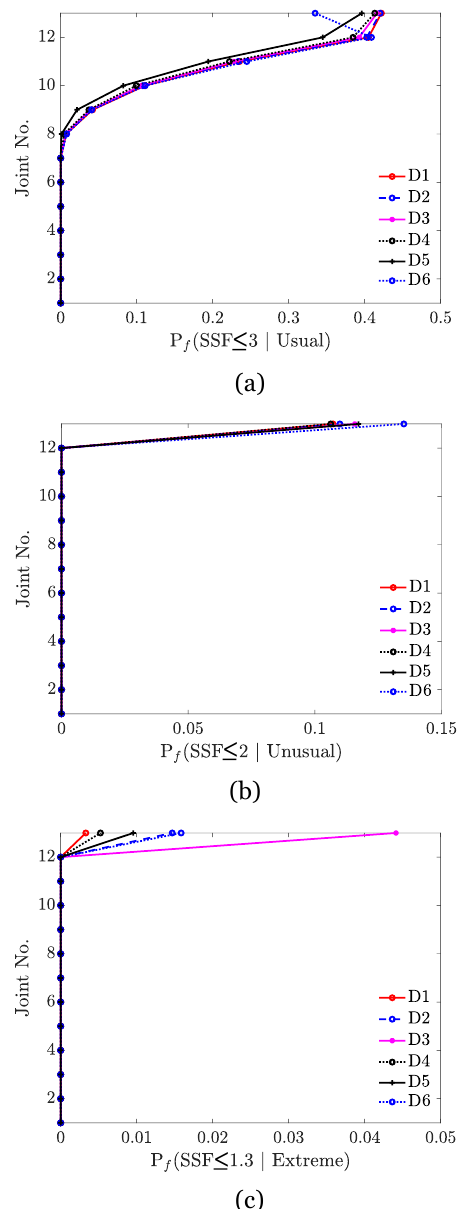
Figure 11. Conditional probability functions: ( a ) usual, ( b ) unusual, and ( c )